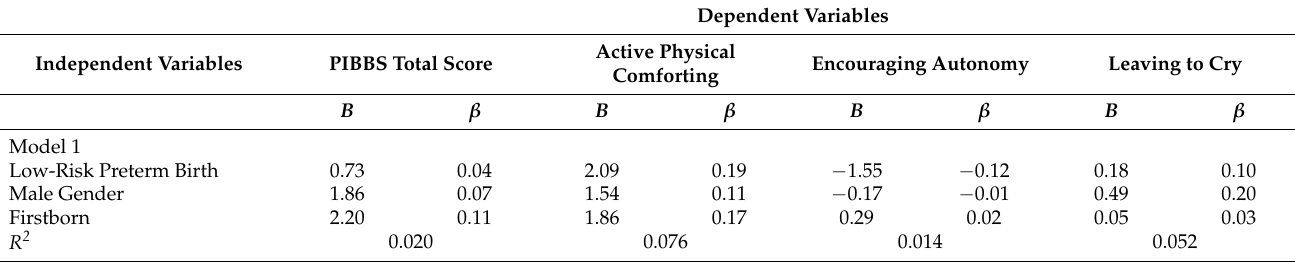
Table 5. Hierarchical Regression Analysis for PIBBS Total Score, Active Physical Comforting, Encour- aging Autonomy, and Leaving to